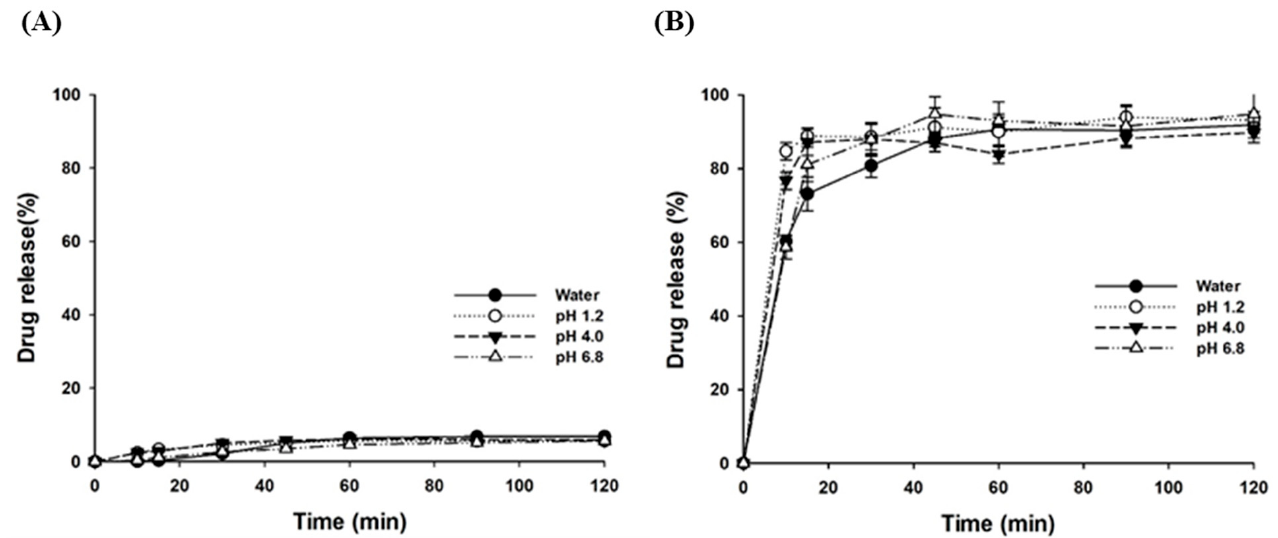
Figure 5. Dissolution profiles of pure curcumin ( A ) and LSD-F3 ( B ) at different pH values (Mean ± SD, n =